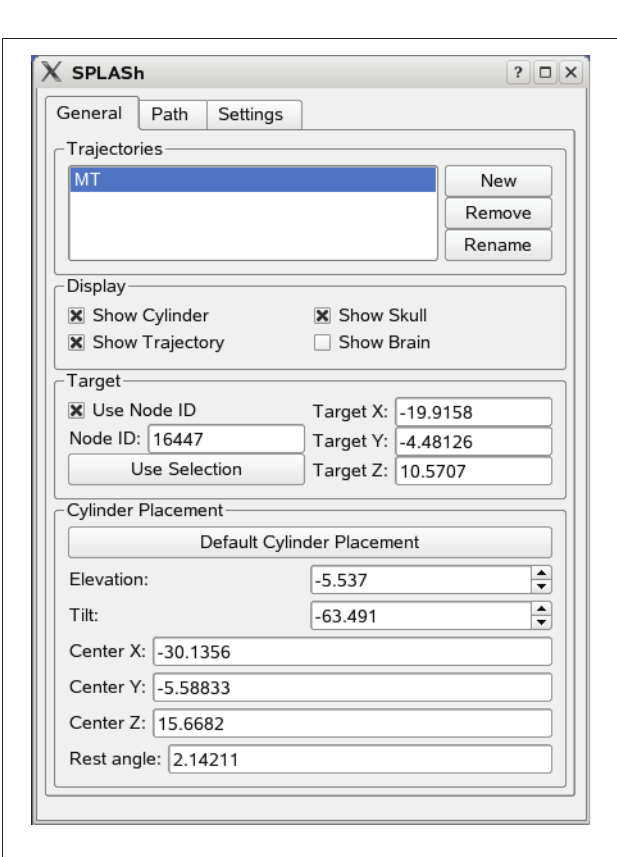
Figure 4 | Main SPLASh user interface. The “Target” section contains information about the stereotactic location of the recording target. The “Cylinder Placement” section contains information about the stereotactic location and the orientation of the recording